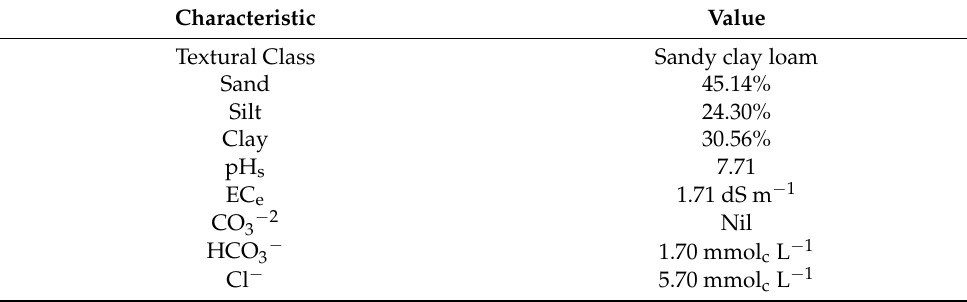
Table 1. Physico-chemical properties of soil used for